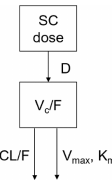
algorithm was applied to each tissue slice for objective quantitative analysis after the algorithm